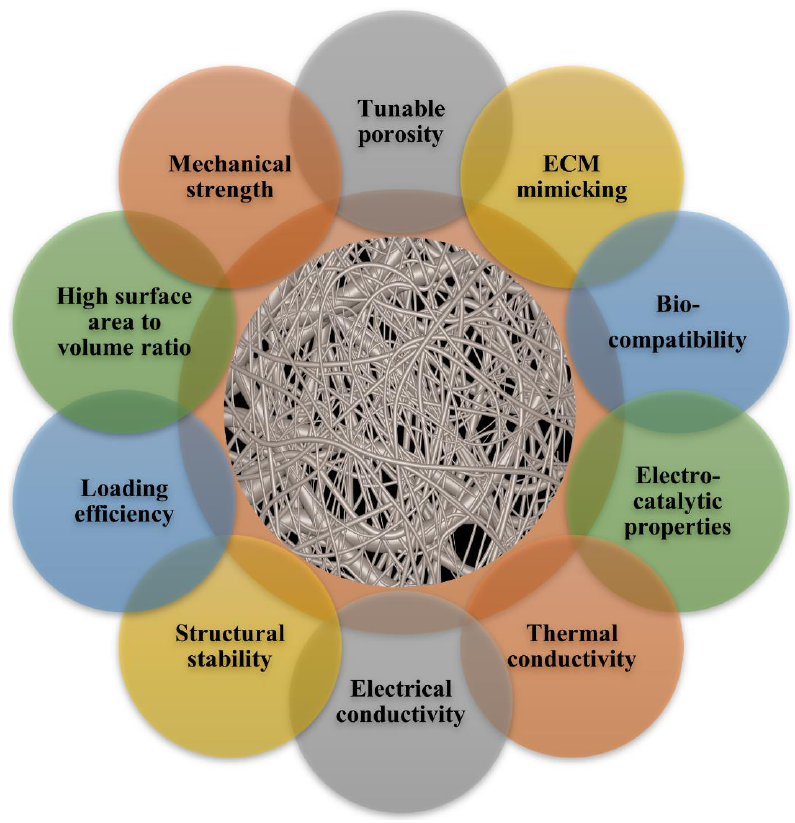
Polymers 2022 , 14 , x FOR PEER REVIEW Figure 7. Key properties of electrospun nanofibers. Figure 7. Key properties of electrospun nanofibers.